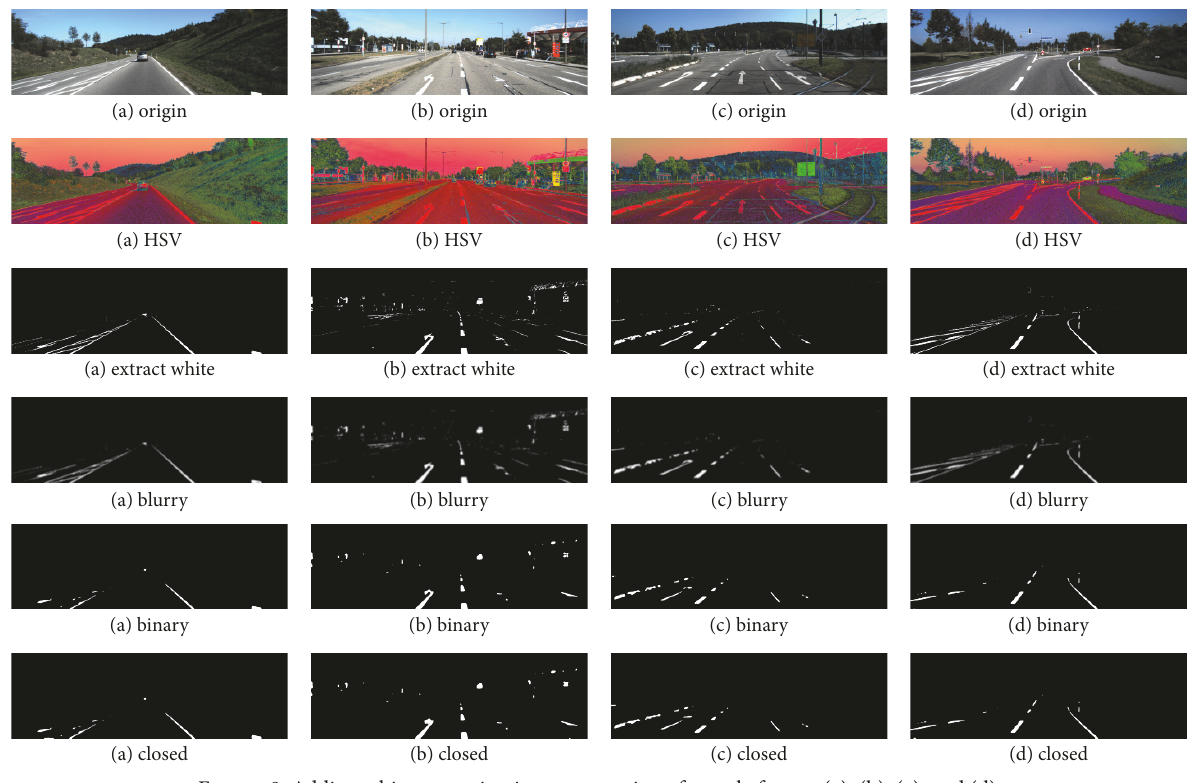
Figure 8: Adding white extraction in preprocessing of sample frames (a), (b), (c), and (d).